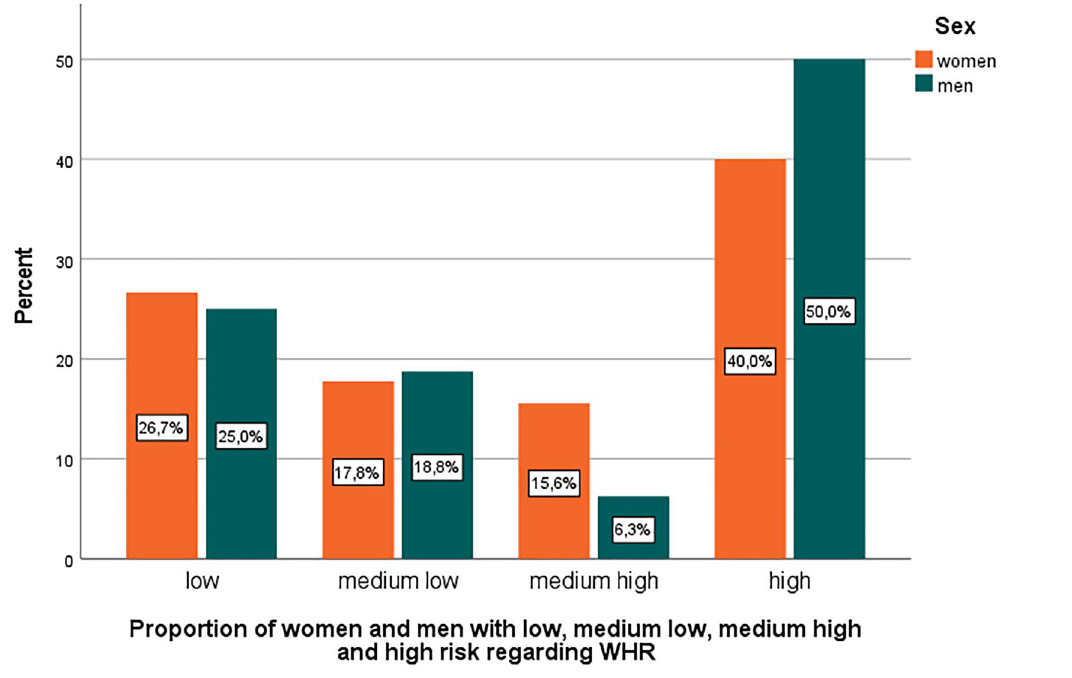
Figure 3. Proportion of women and men with low, medium low, medium high and high risk regarding